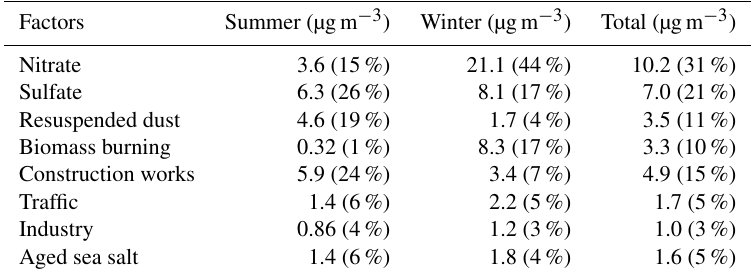
Table 1. Absolute and relative average source contributions to PM 10 mass in the eight-factor constrained